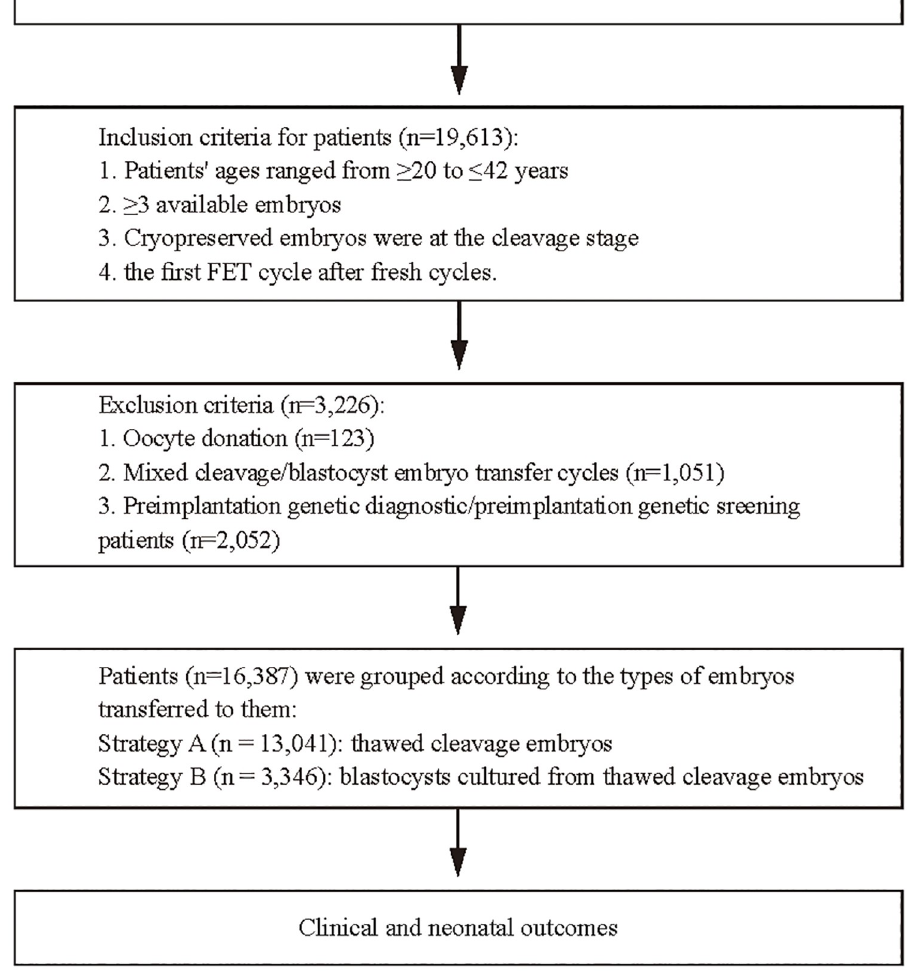
Fig 1. Flowchart of study